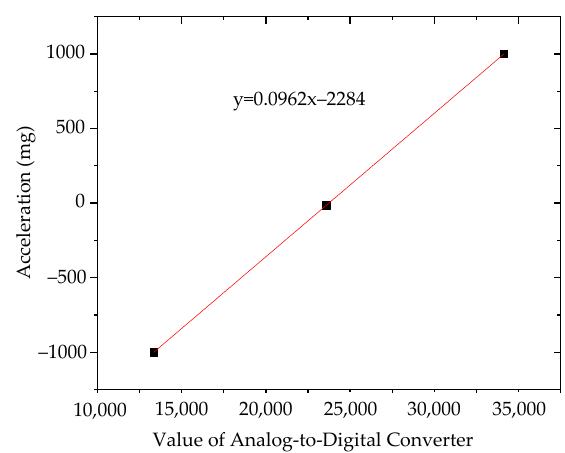
Figure 16. Sensor No. 1.